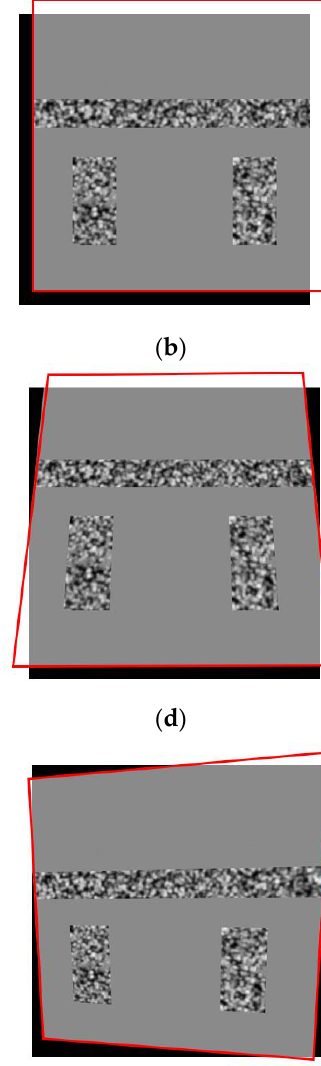
11 of 21 Figure 7. Video images (units: pixel). The sampling frequency of the camera is set as 30 Hz, and the camera is supposed to move during shooting, including translation, yaw, pitch, roll, and their combination, as shown in Figure 8. The camera moving cases are set as follows: Case 1: The translation of the camera in both the U and V directions of the image is